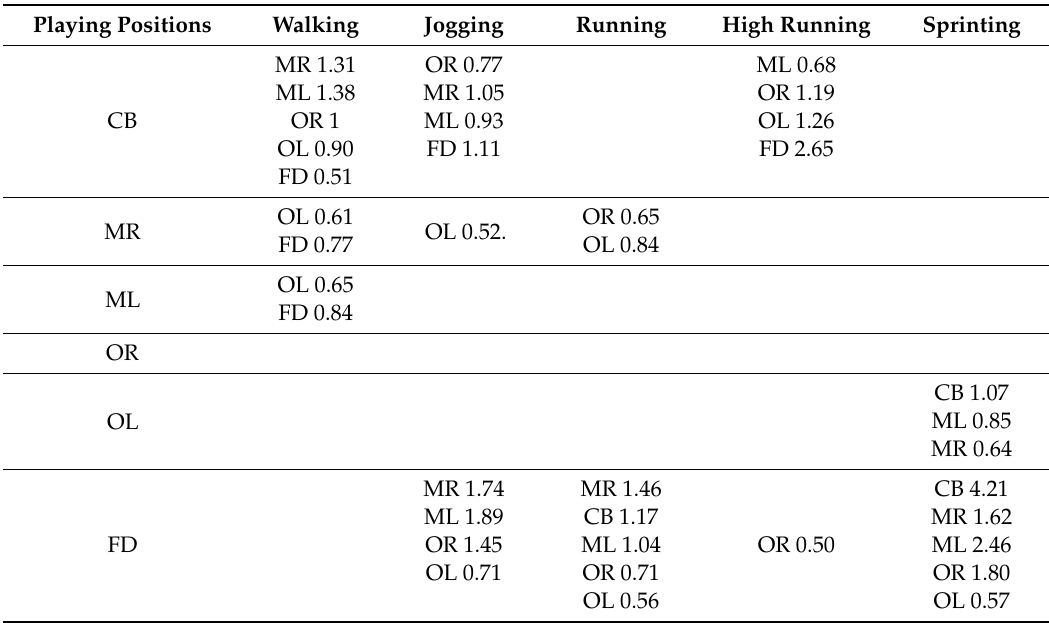
Legend: center back = CB; mid right = MR; mid left = ML; outside right = OR; outside left = OL; front center defender = FD.